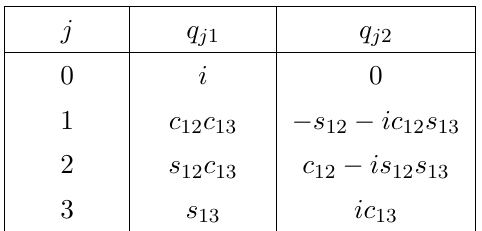
Table 4 . Invariant combinations of the neutral Higgs boson mixing angles (cid:18) 12 and (cid:18) 13 , where c ij (cid:17) cos (cid:18) ij and s ij (cid:17) sin (cid:18) ij . where Z (cid:17) Z + Z + Re Z 345 3 4 5